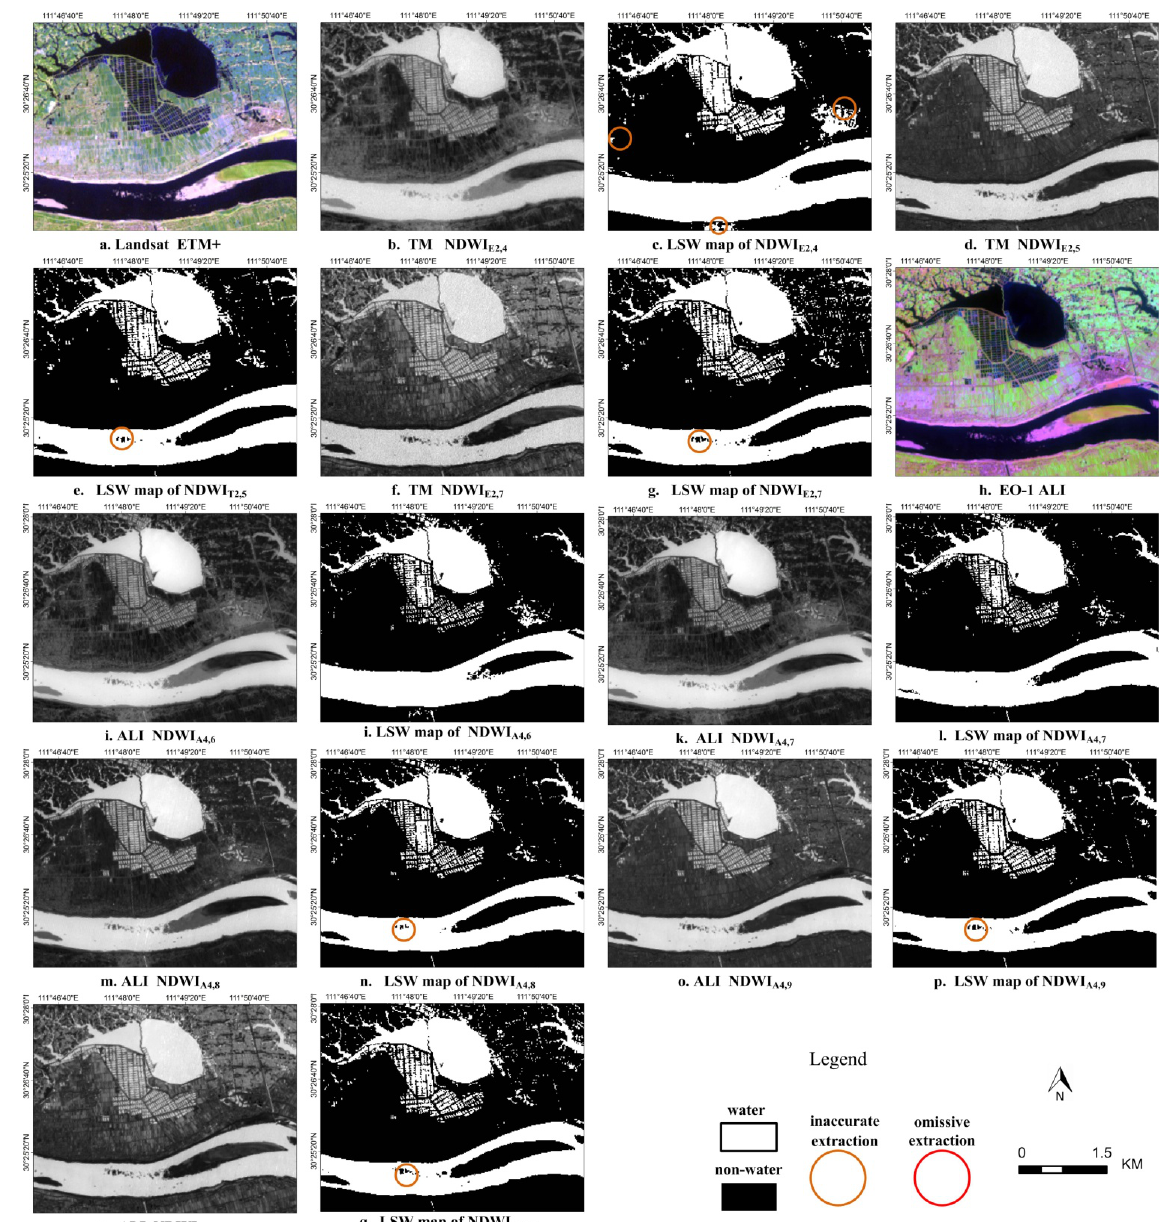
Figure 4. Original images and the LSW map results from Landsat ETM+ imagery and EO-1 ALI imagery in Region III. ( a ) Landsat ETM+ image (29 March 29 2003) false-color composite (RGB:753); ( b ) NDWI calculated from ETM+ Bands 2 and 4; ( c ) LSW map of ; ( d ) NDWI calculated from ETM+ Bands 2 and 5; ( e ) LSW map of NDWI ; NDWI E2,4 E2,5 ; ( h ) EO-1 ( f ) NDWI calculated from ETM+ Bands 2 and 7; ( g ) LSW map of NDWI E2,7 ALI image (29 March 29 2003) false-color composite (RGB: 965); ( i ) NDWI calculated ; ( k ) NDWI calculated from ALI from ALI Bands 4 and 6; ( j ) LSW map of NDWI A4,6 ; ( m ) NDWI calculated from ALI Bands 4 and 8; Bands 4 and 7; ( l ) LSW map of NDWI A4,7 ; ( o ) NDWI calculated from ALI Bands 4 and 9; ( p ) LSW map ( n ) LSW map of NDWI A4,8 ; ( q ) NDWI calculated from ALI Bands 4 and 10; ( r ) LSW map of NDWI of NDWI A4,9 A4,10